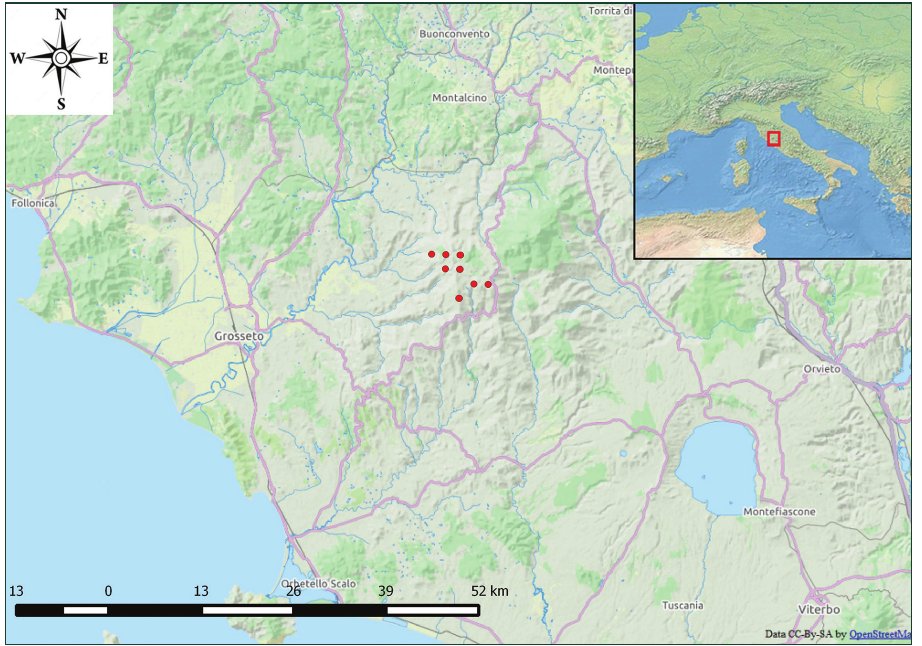
Figure 8. Geographic range and distribution map of Armeria saviana